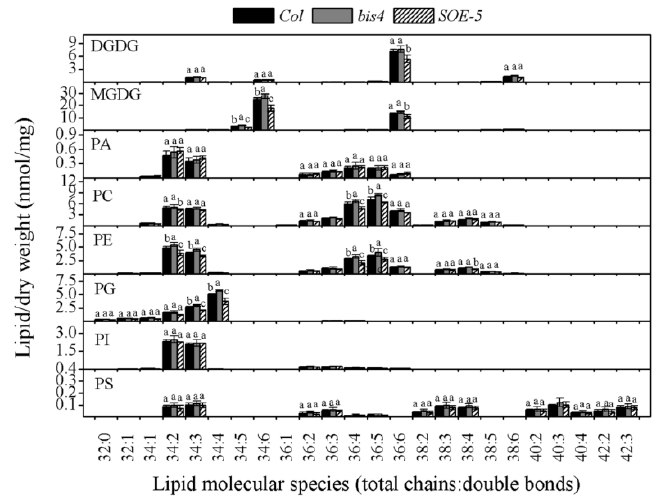
Figure 4. Changes in the molecular species of lipids in Col, bis4, and SOE-5 plants. The values are the means ± SDs ( n = 4 or 5). Bars for the same lipid class with different letters indicate that the values were significantly different ( P < 0.05).